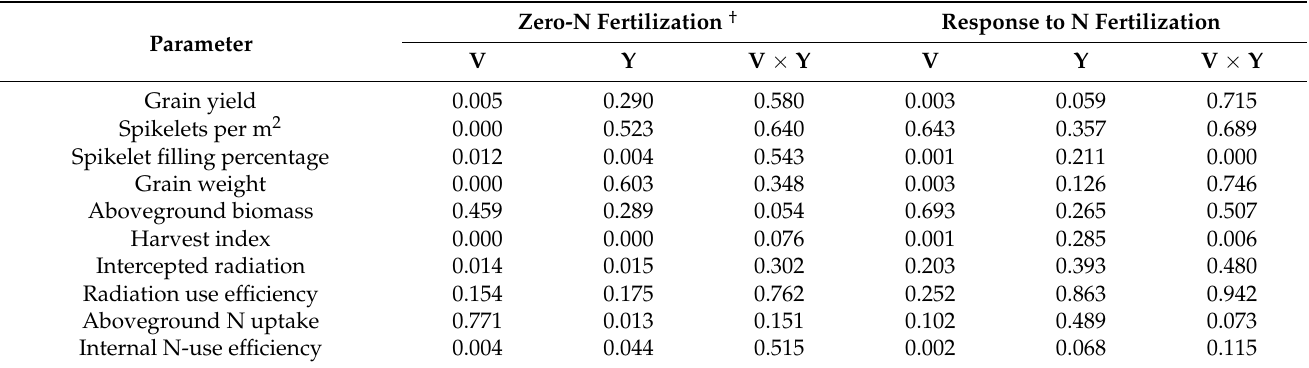
Table 2. Analysis of variance ( p -values) for all parameters measured under the zero-N fertilization